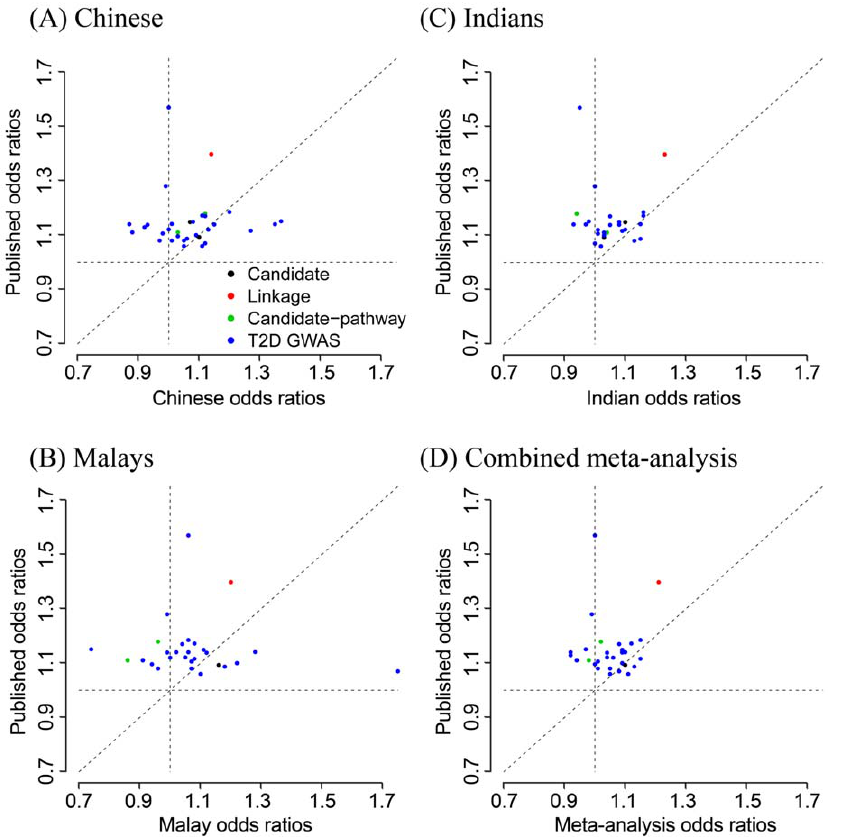
Figure 1. Bivariate plots comparing odds ratios observed in each of the ethnic groups with odd ratios established in populations of European ancestry. (A) Chinese, (B) Malays, (C) Indians, (D) Combined meta-analysis. Each SNP is plotted with a colour that indicates if the SNP was identified through candidate gene studies (black) or linkage studies (red) or candidate-pathway analysis (green) or T2D genome-wide scans (blue).